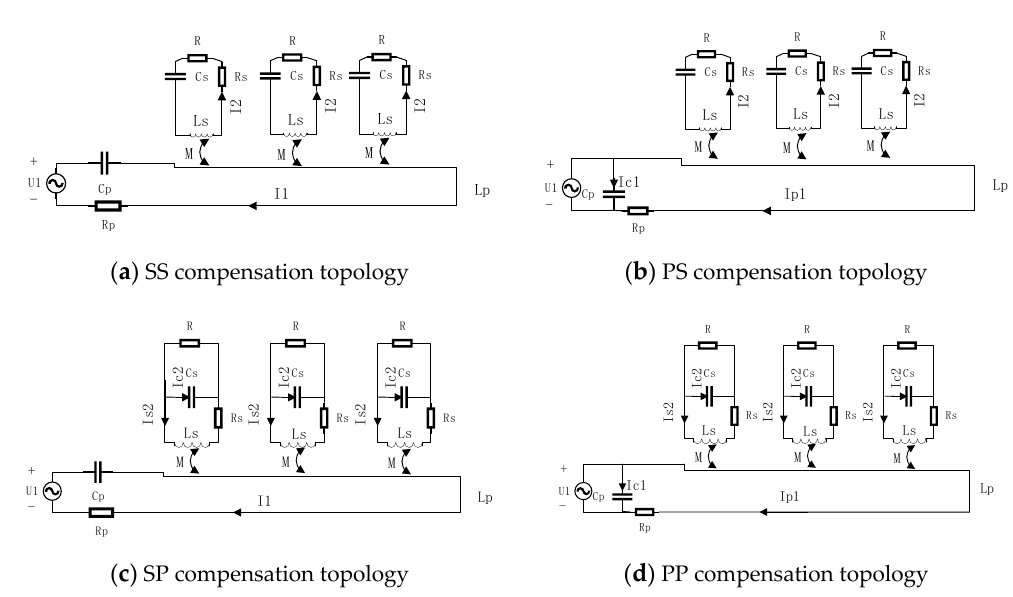
Figure 1. Four basic compensation topologies of inductive wireless power transfer system. PP—parallel–parallel; PS—parallel–series; SP—series–parallel; SS—series–series.